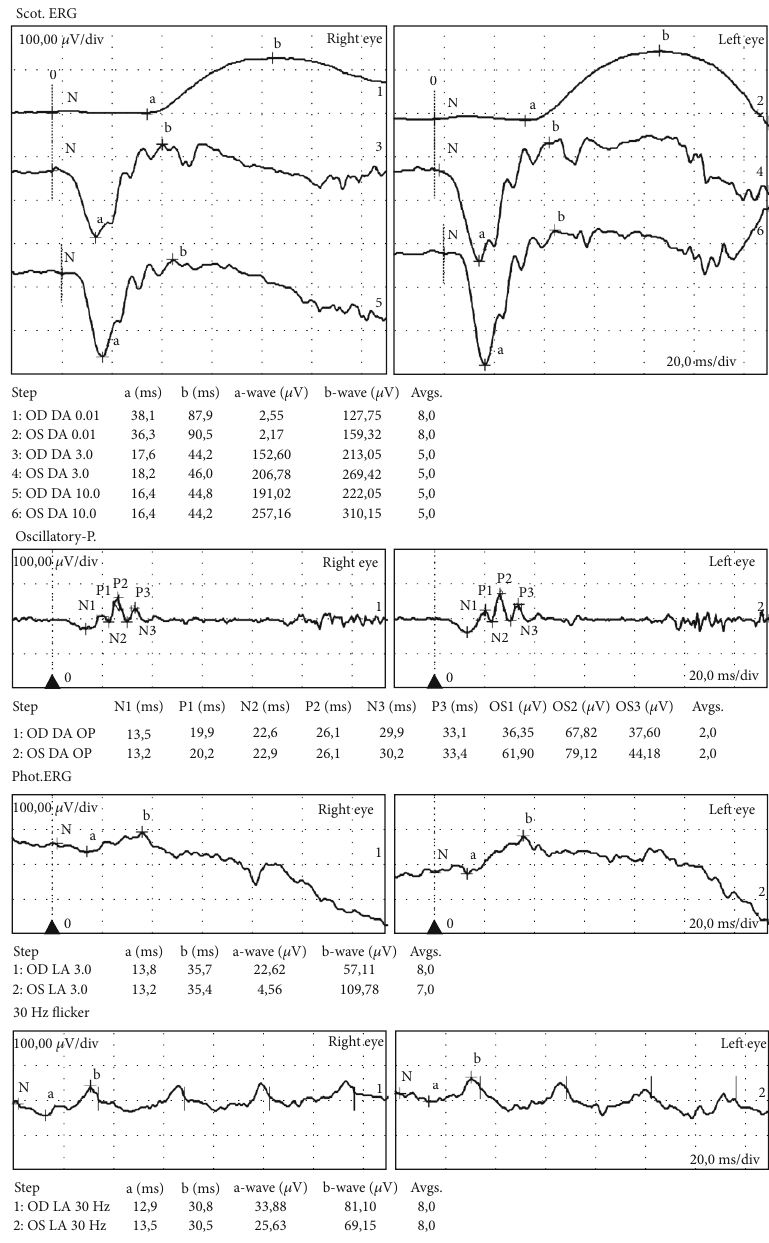
Figure 2: Full fi eld ERG